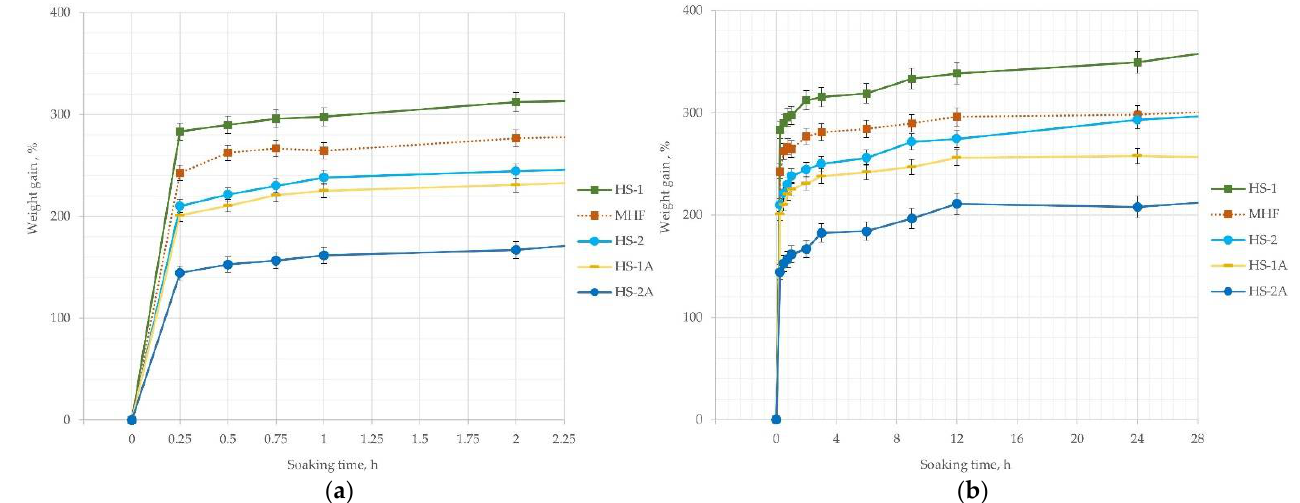
Figure 6. Water absorption—increase in mass of hemp board samples: ( a ) weight gain in 2 h; ( b ) weight gain in 24 h.